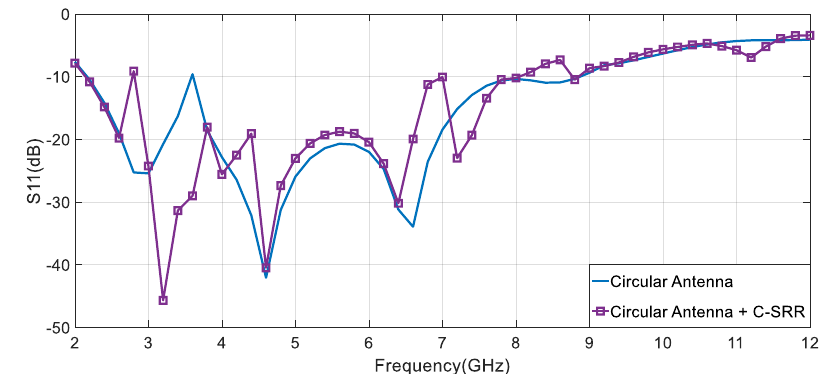
Figure 22. ( a ) Antenna front side ( b ) antenna back.